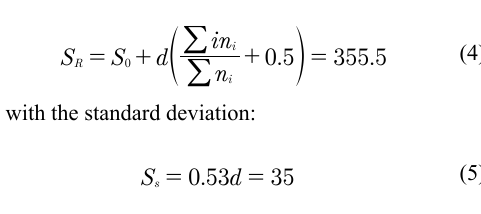
Table 5. Basquin’s constants equation and upper and lower bound constants S-N curve for 95% confidence level Constant